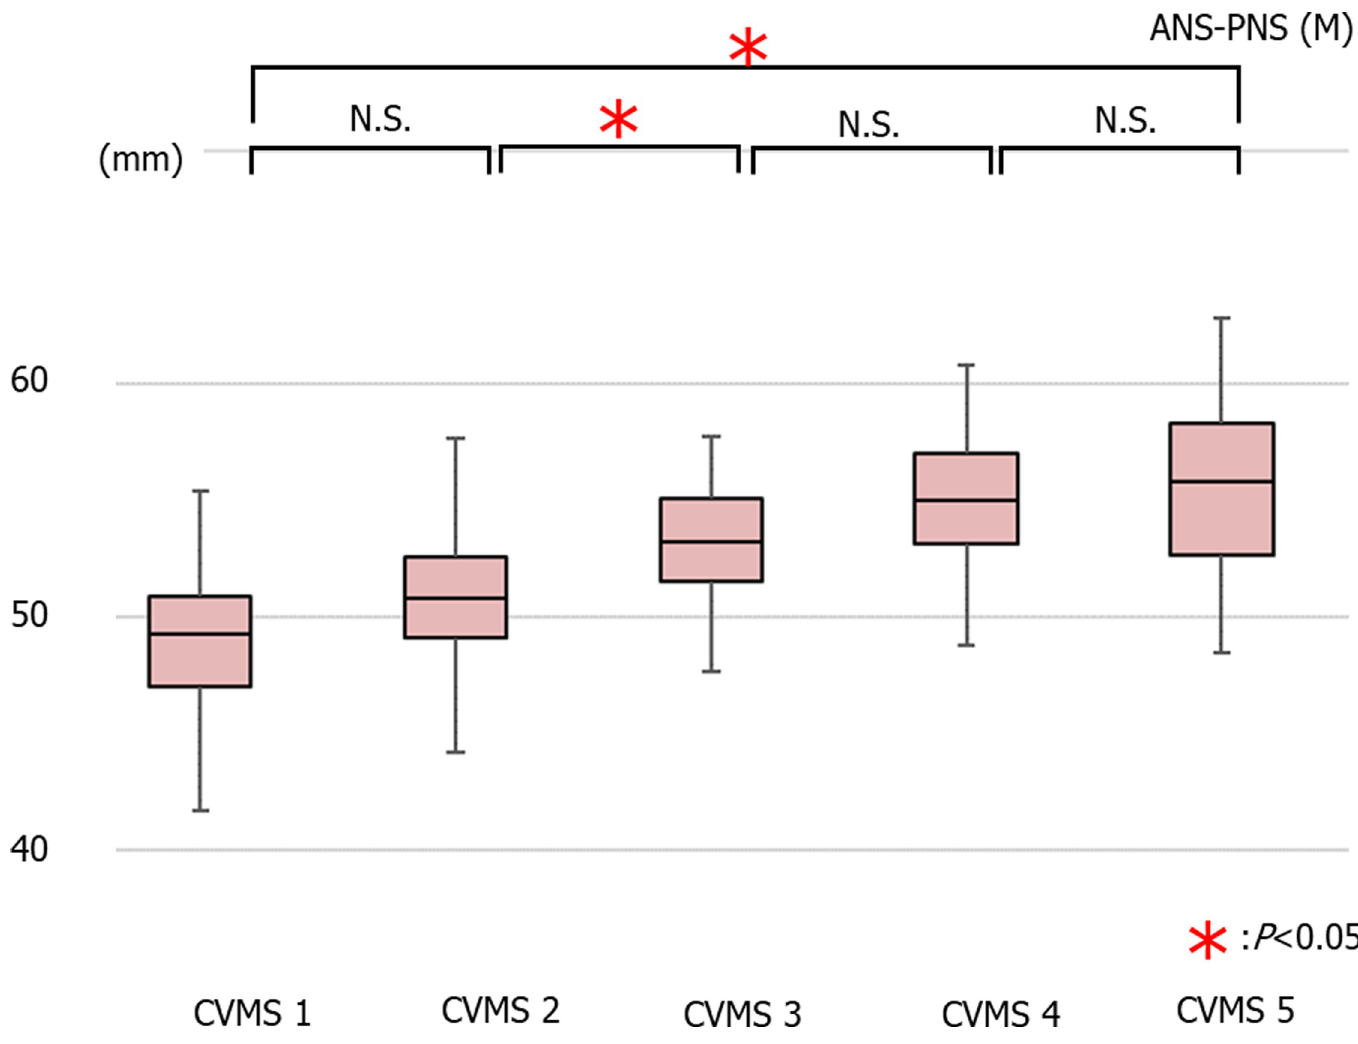
Fig 2. The average values of ANS-PNS in males ( � p <